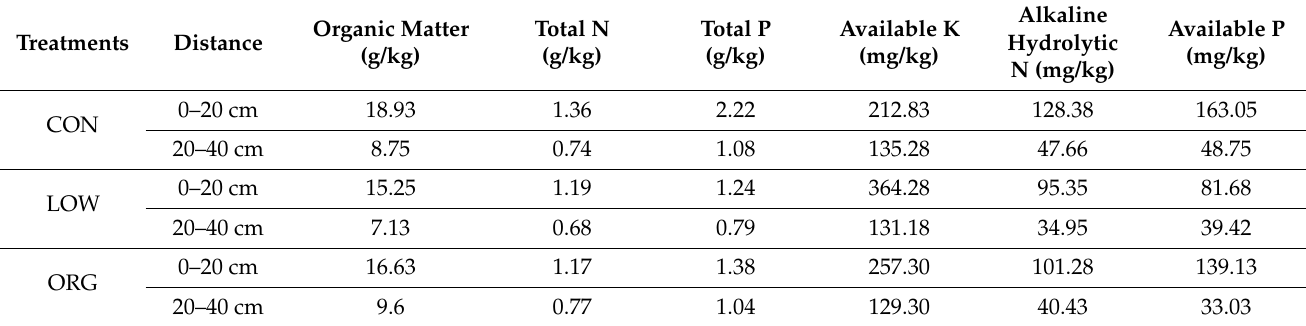
Table 1. The initial basic soil properties recorded in the greenhouse